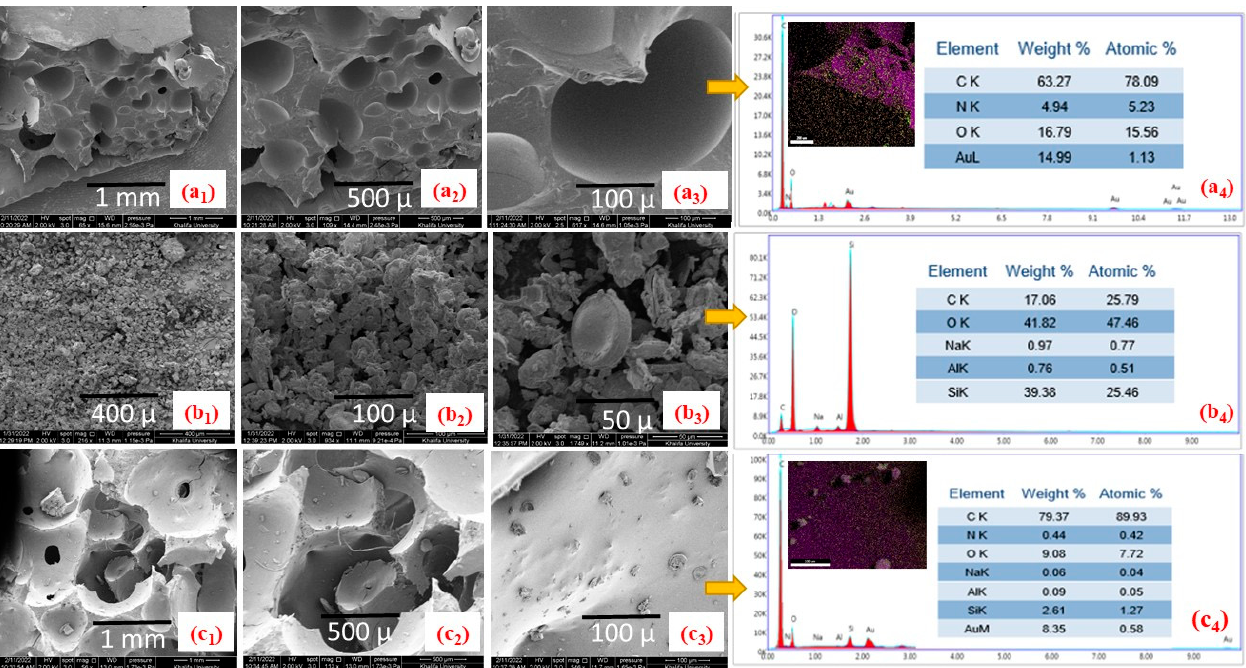
Figure 2. SEM images on different scales: ( a1 – a3 ) pristine PU synthesized foam, ( b1 – b3 ) C18-DE, ( c1 – c3 ) modified PU-C18-DE foam, EDX graph mapping and elemental analysis for all three samples, respectively, ( a4 ), ( b4 ), ( c4 ).